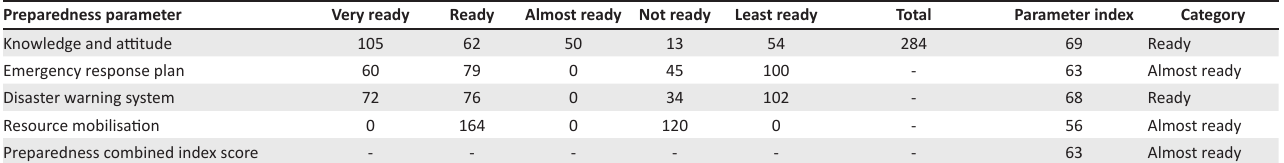
TABLE 6a: Student preparedness for forest and land fires.